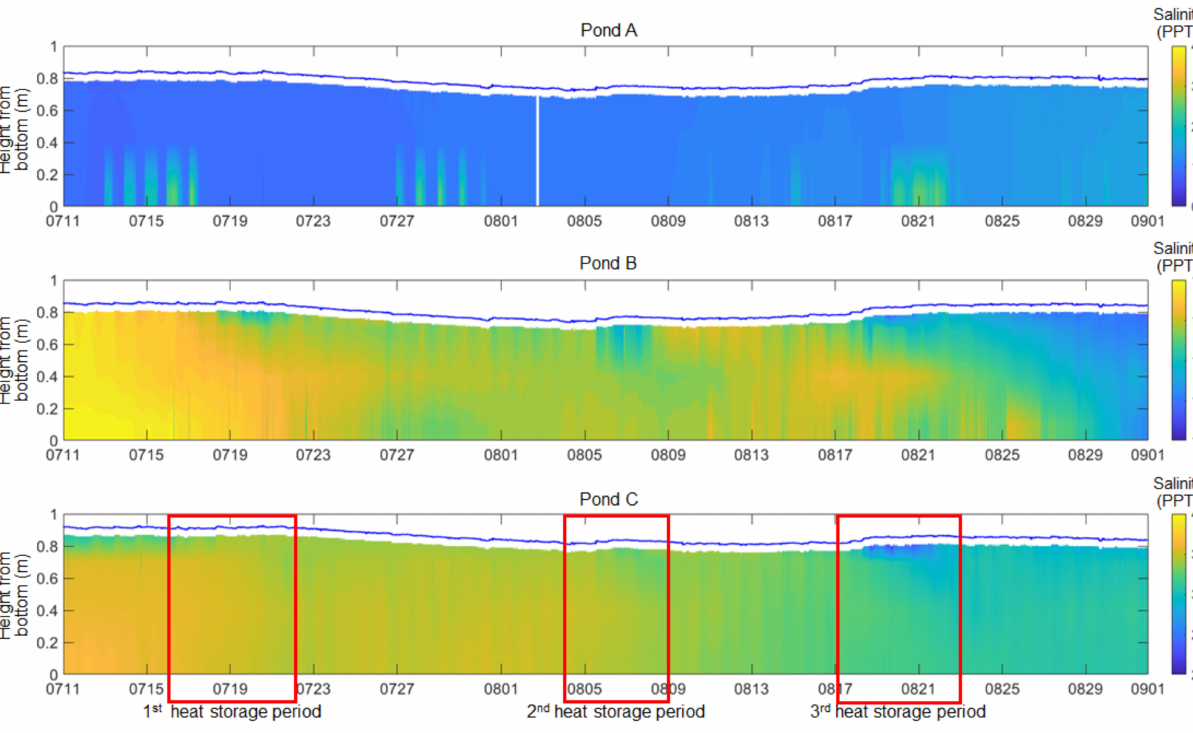
Figure 5. Salinity concentration variation time-series. The blue line indicates the fluctuation of water level. Red rectangles indicate the heat storage period in Pond